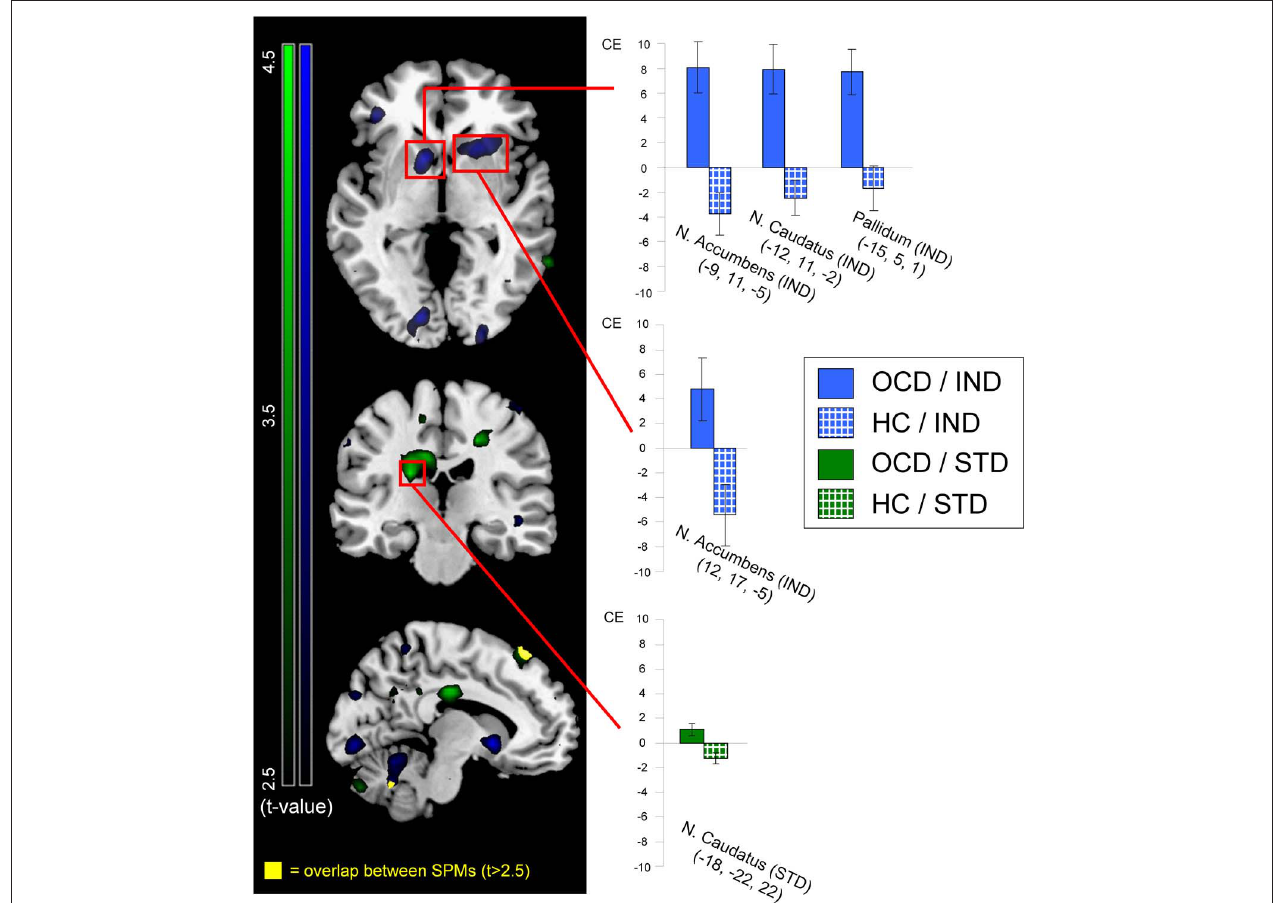
FIGURE 3 | Neural activation of patients (OCD; solid colors) greater than healthy controls (HC; patterned) contrasted for individualized (IND; blue) and standardized (STD; green) symptom provocation. The figure displays statistical parametrical maps with whole-brain t -values for the between-group contrasts (OCD > HC) for both symptom provocation approaches. For illustration reasons, data were thresholded with t > 2 . 5 (see color bars for exact t -values) and displayed on a standard MNI brain template. Significant results from the voxel-wise ROI analyses are marked with red